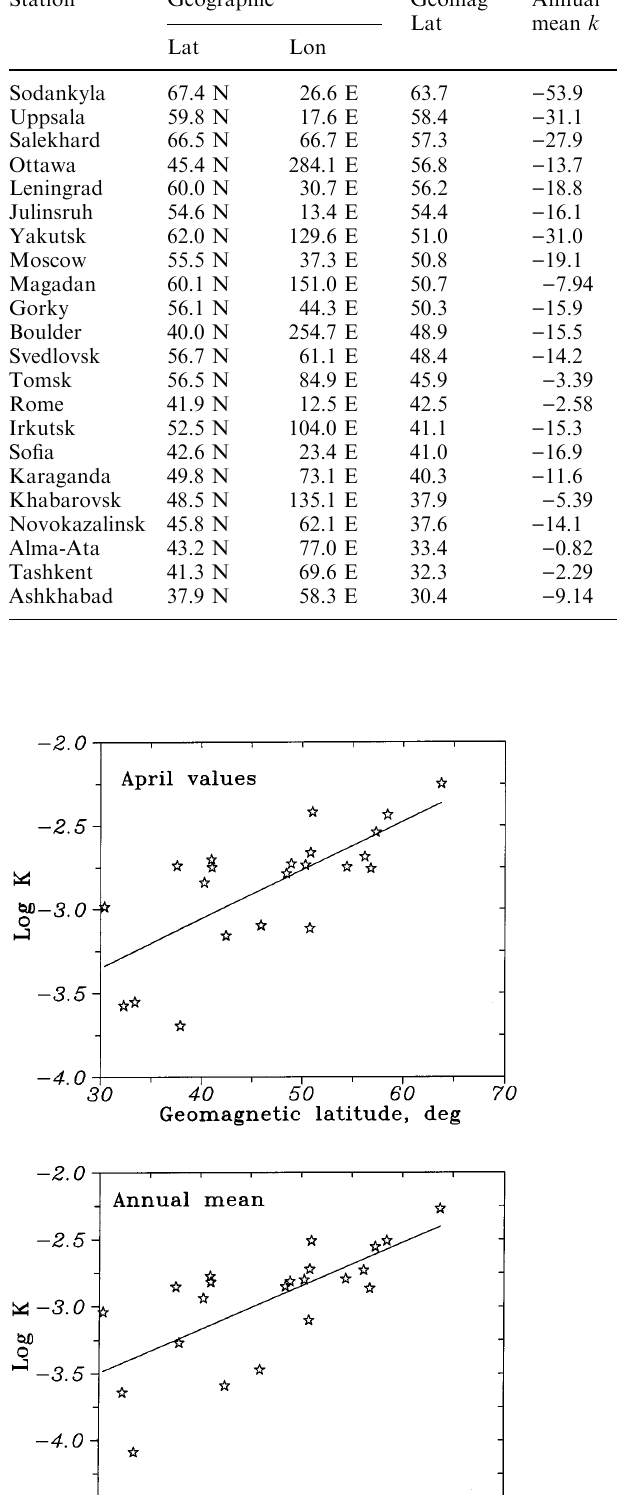
Table 1. Ionosonde stations and calculated annual mean slope k (in 10 ) 4 units/per year) Station